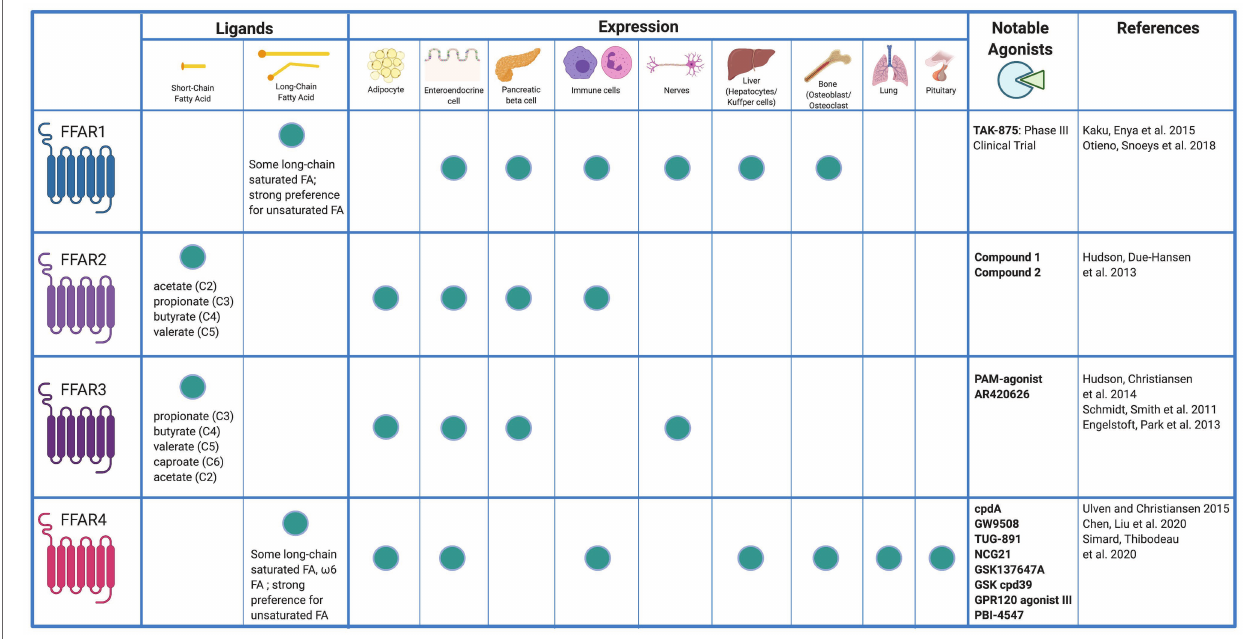
FIGURE 1 | Free fatty acid receptor distribution and agonists. Created with Biorender.com